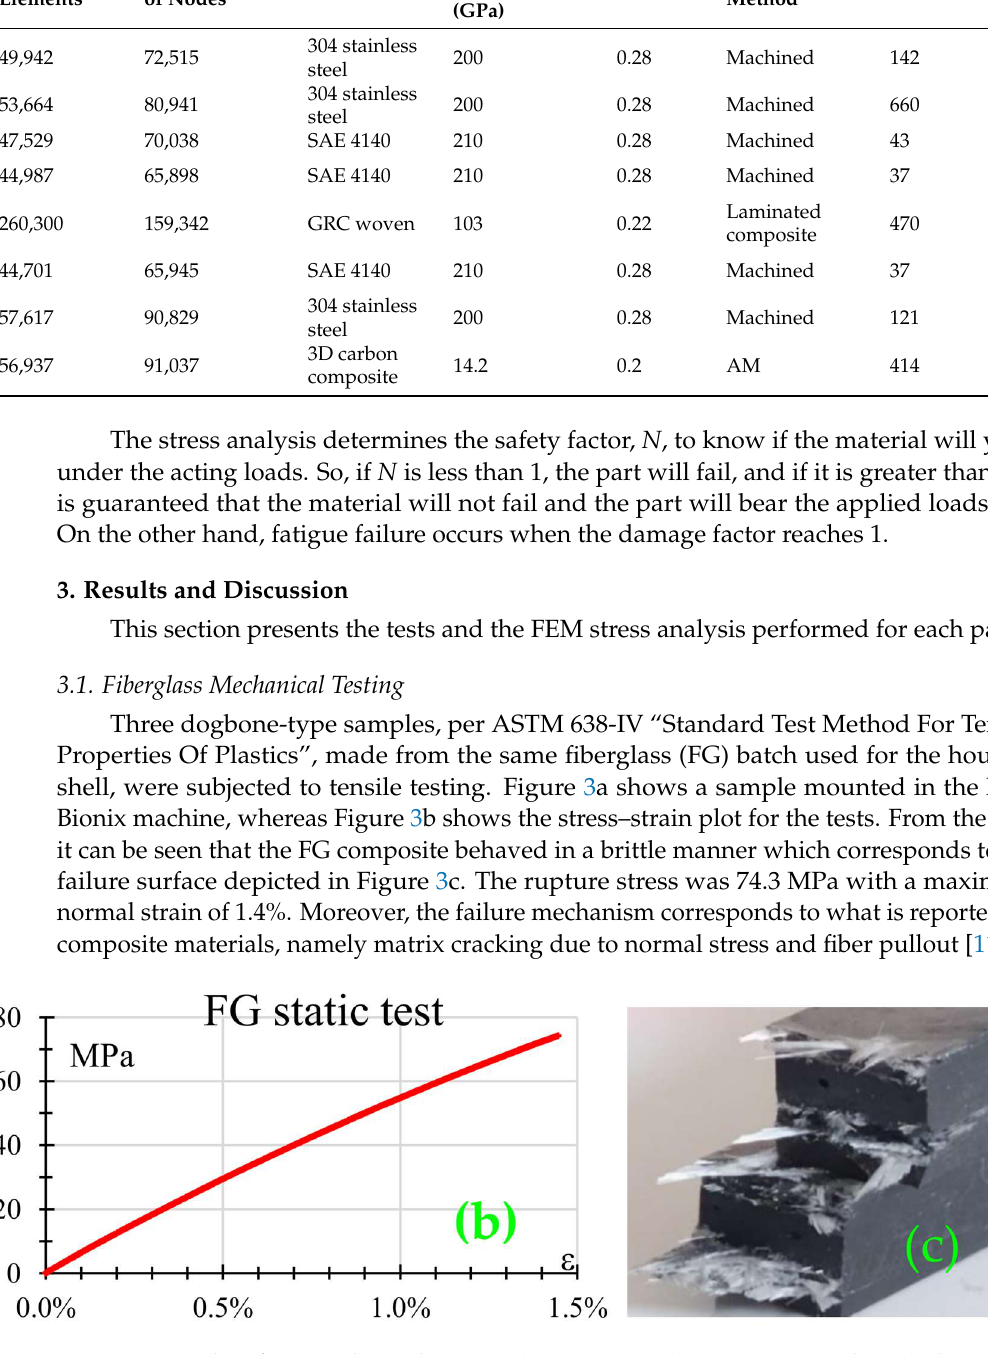
Figure 3. Results of FG mechanical testing: ( a ) test setup; ( b ) stress–strain plot; ( c ) close-up of ruptured sample.